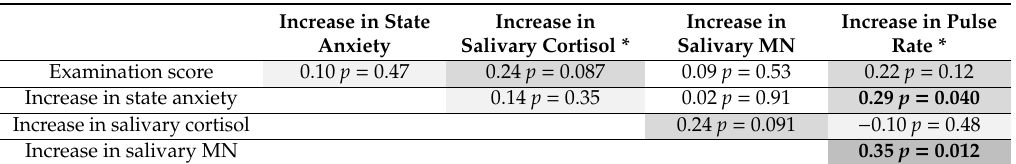
Table 2. Intercorrelation of the outcome measures: Pearson’s r coe ffi cients together with p -values are reported for the correlations of final examination scores and “basal” to “preexamination” increase in the rest of the measures. Statistically significant results are presented in bold.